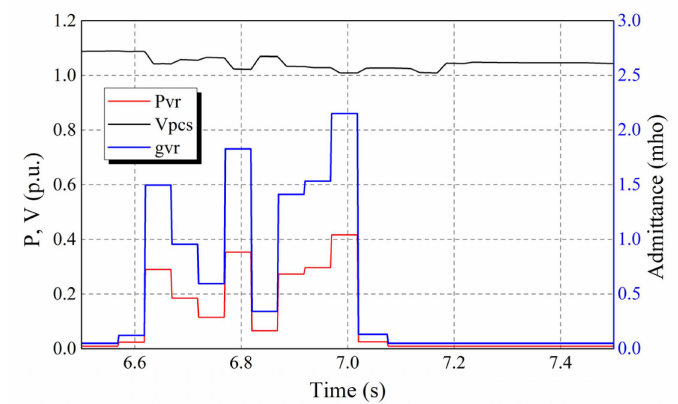
Figure 15. Admittance and pcs voltage variation in Case 2 (6.5–7.5